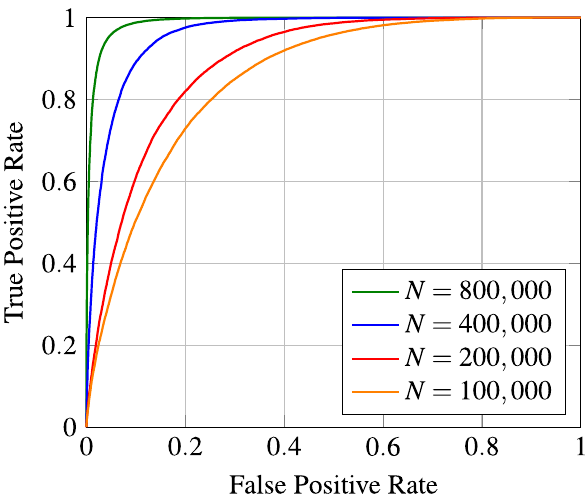
− 4 . During training, the fixed